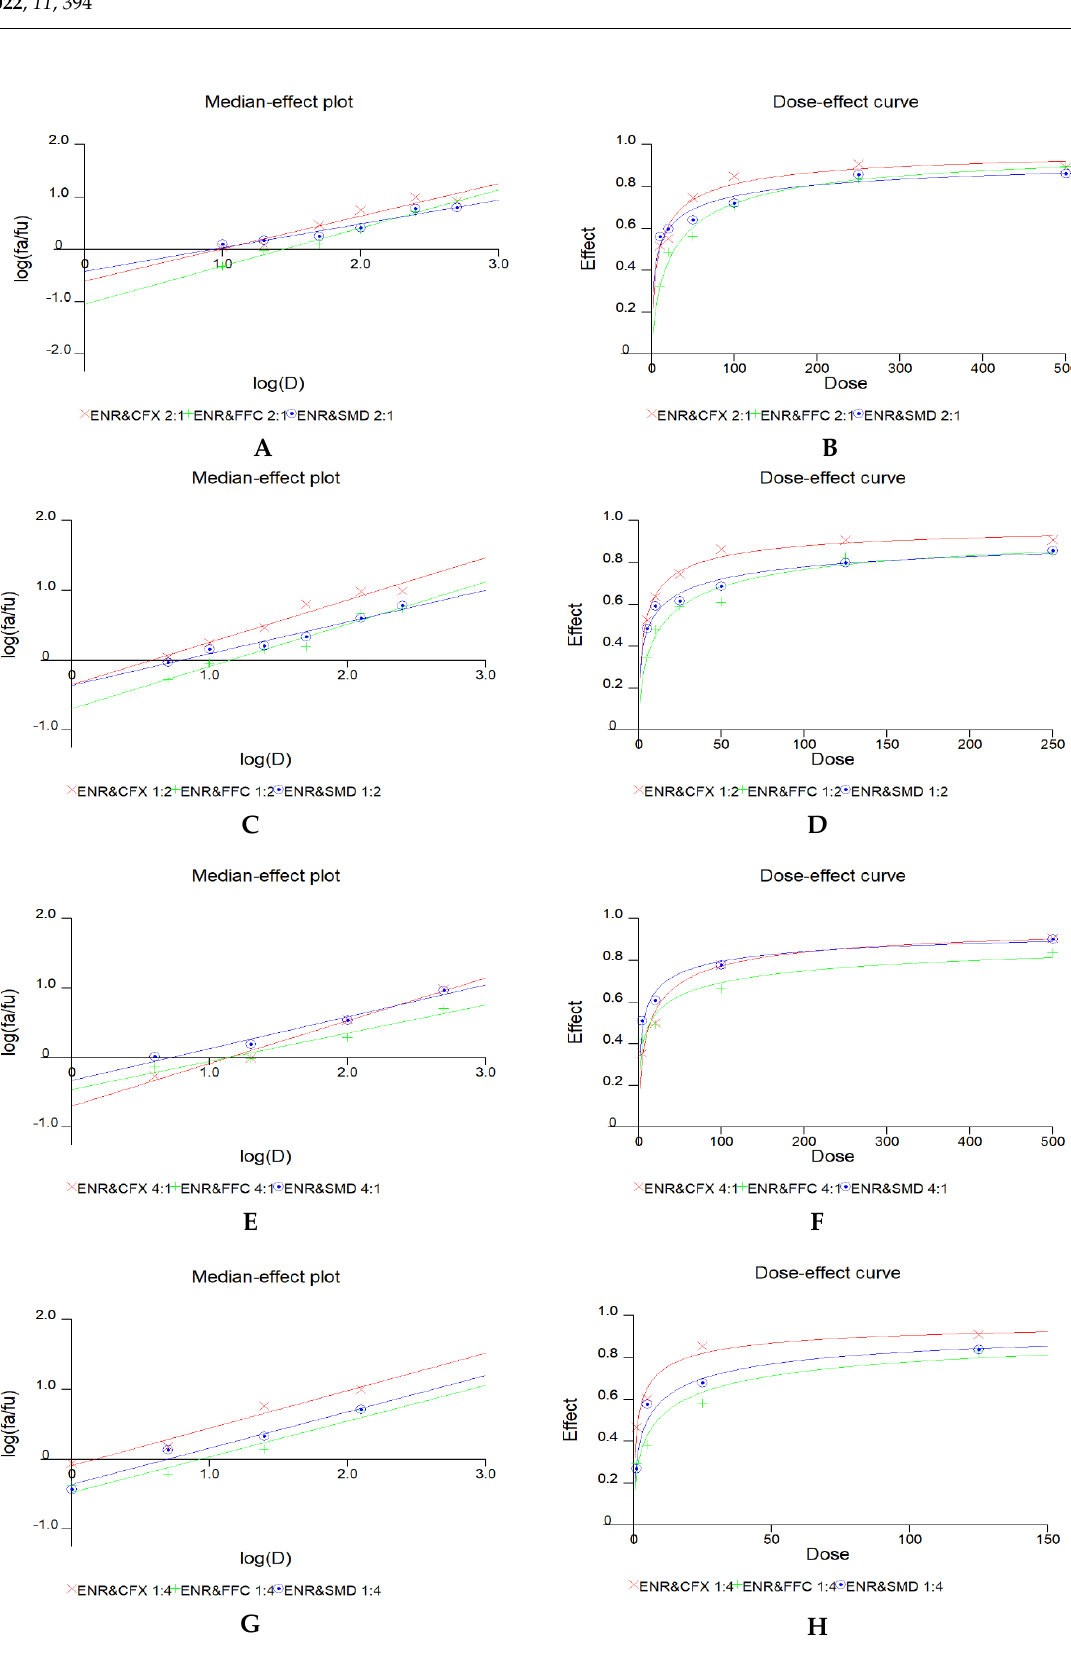
Figure 2. A caption on a single line should be centered. Median-effect plots and dose–effect curves of binary drug combinations mixed at a ratio of 1:2 ( A , B ), 2:1 ( C , D ), 4:1 ( E , F ), and 1:4 ( G , H ). A significant difference was observed in some drug combinations and mixing ratios.